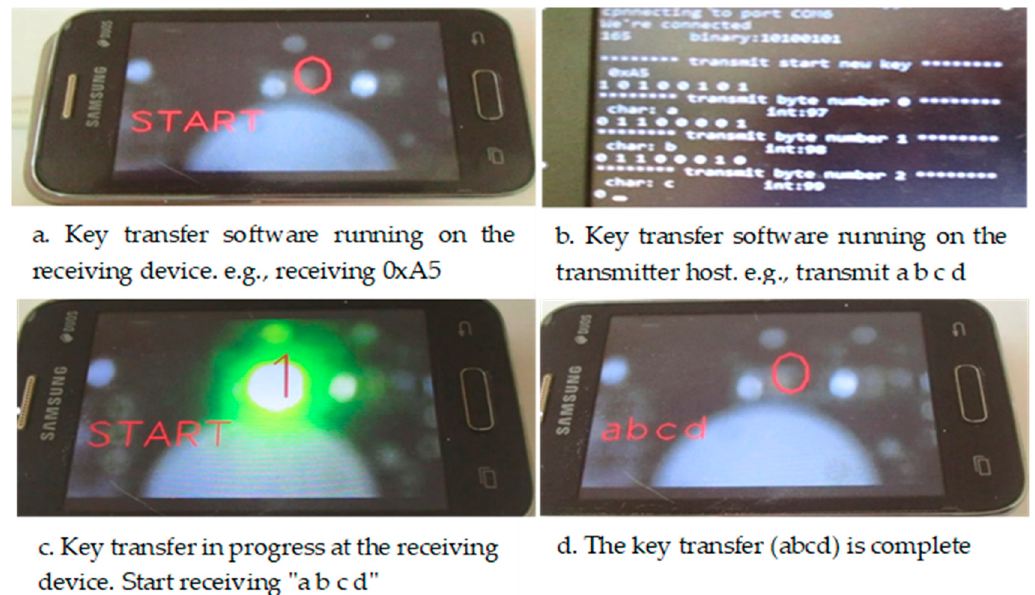
Figure 14. Captured images of the live key transmission stages.